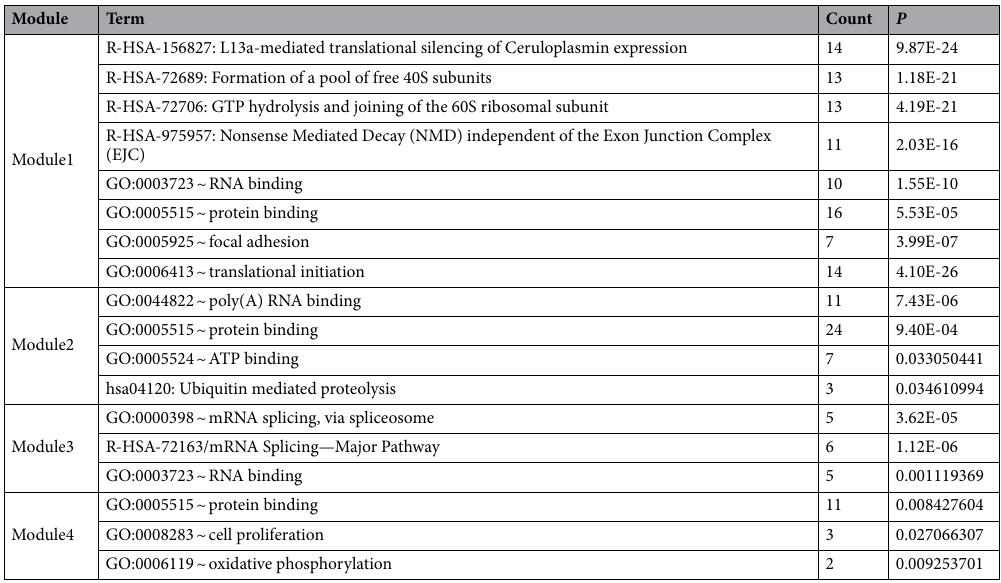
Table 1. Pathway enrichment analysis of Module genes